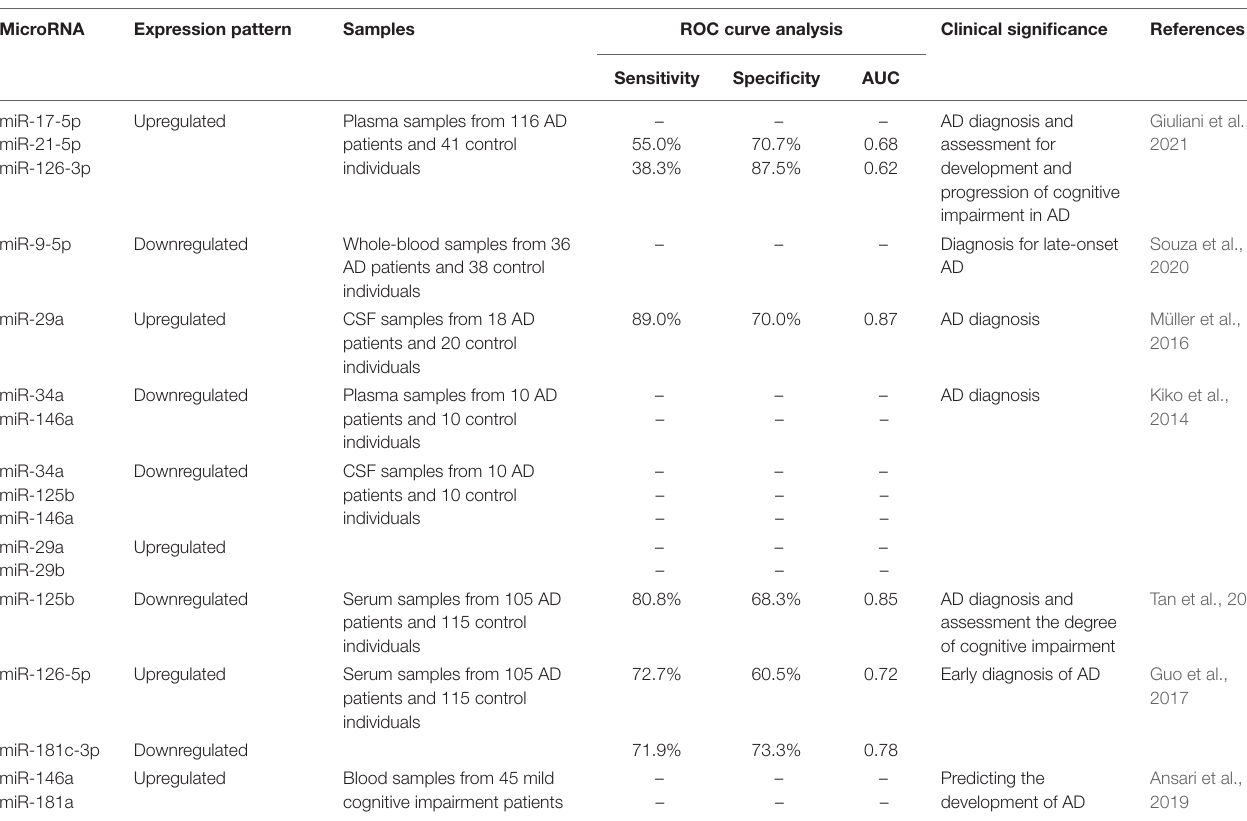
TABLE 2 | Diagnostic role of miRNAs in AD